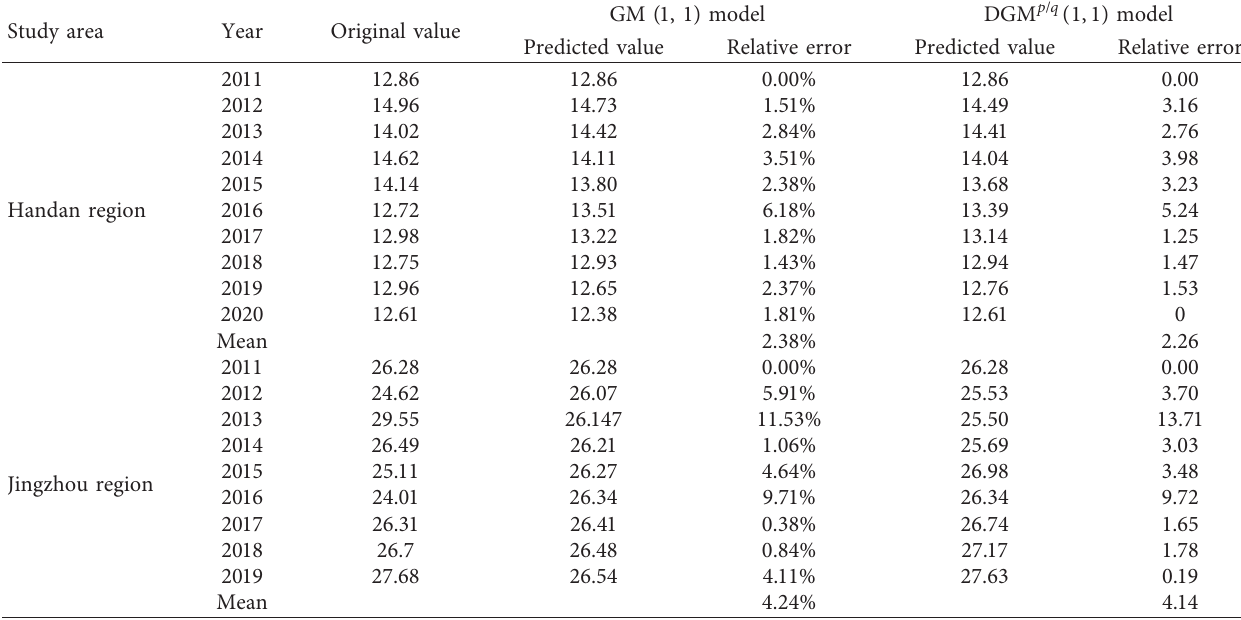
Table 2: Comparison of prediction effect of the model.